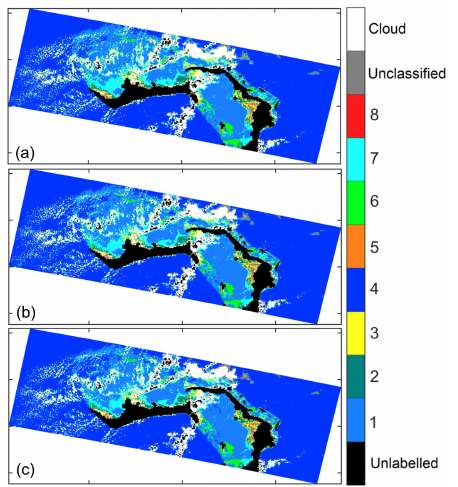
Figure 12. Classification results for Grand Bahamas region using different values of β . ( a ) β = 0.80; ( b ) β = 0.85; ( c ) β = 0.90.